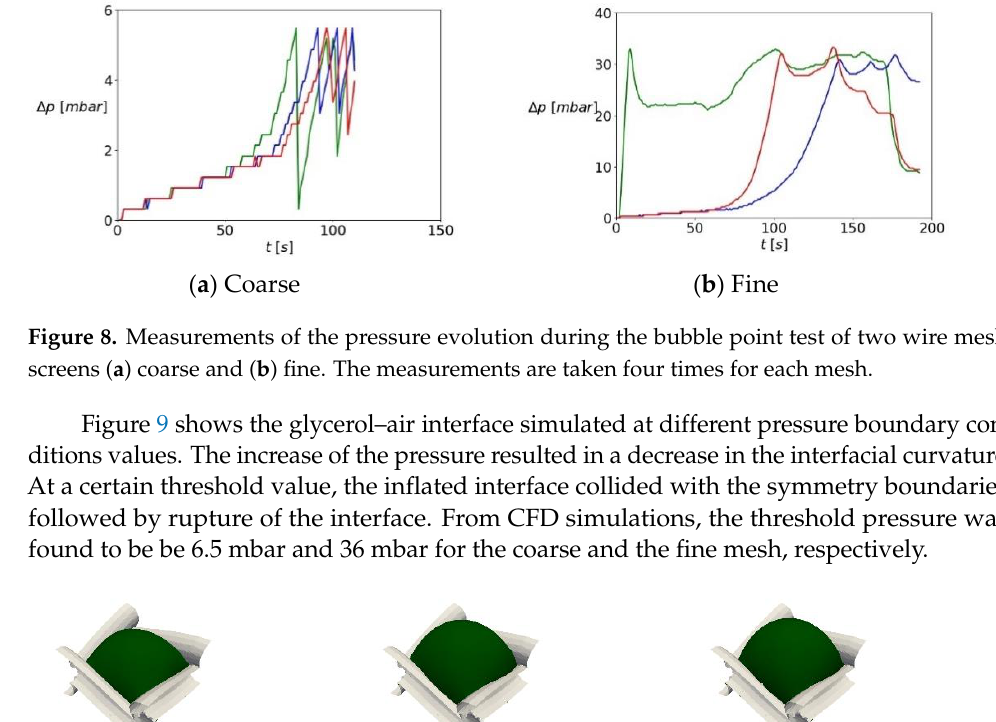
Figure 9. Shape of the glycerol–air interface (green) at different pressure boundary conditions (val- ues).